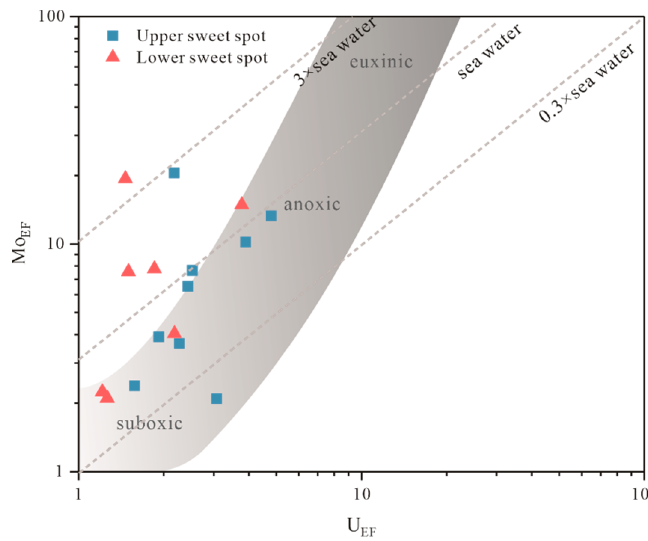
Figure 14. U EF vs. Mo EF for late Pliensbachian–early Toarcian samples. The diagonal lines represent multiples (0.3, 1, and 3) of the Mo:U ratio of present-day seawater [93,94].